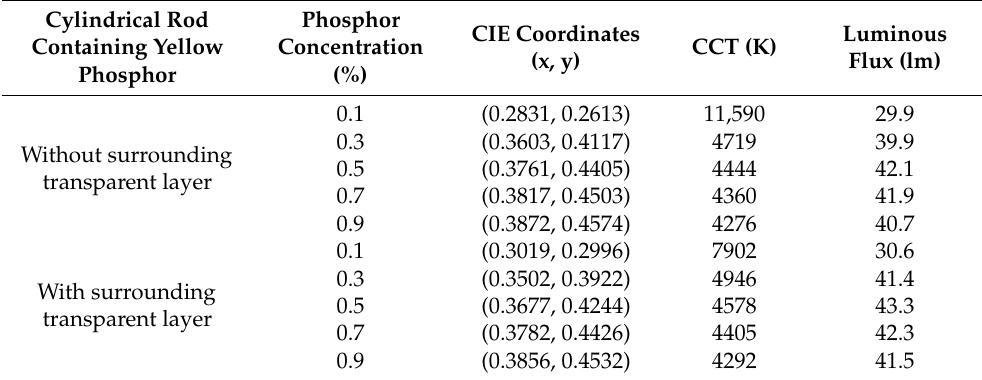
Table 1. Optical characteristics of the cylindrical rod containing yellow phosphor with or without surrounding transparent layer for laser-driven white